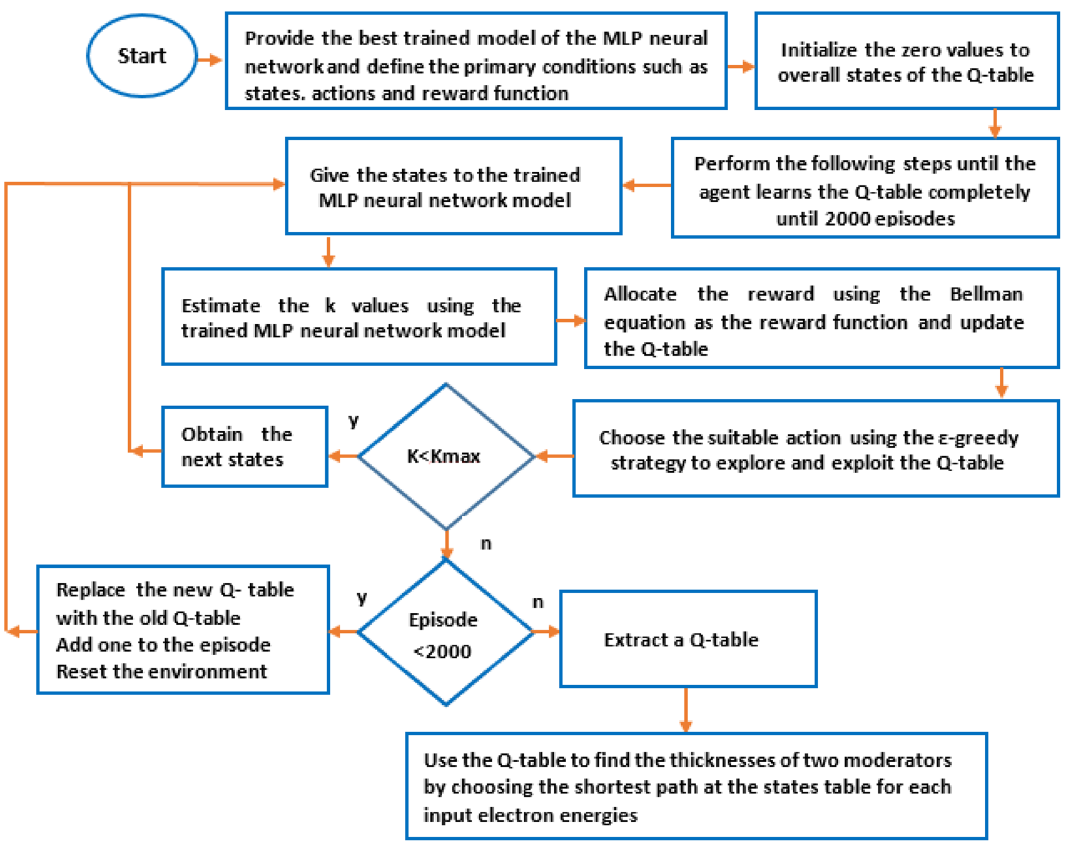
Figure 10. The flowchart of the performance of our hybrid Q-learning algorithm + the MLP neural